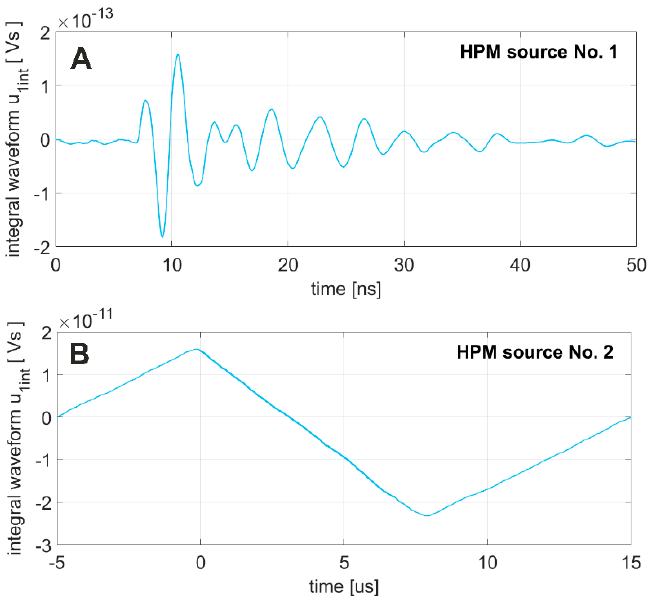
Figure 6. Waveforms of signal integrals from Figure 4 after removing the ordinary mean: ( A ) Marx generator; ( B ) magnetron generator.